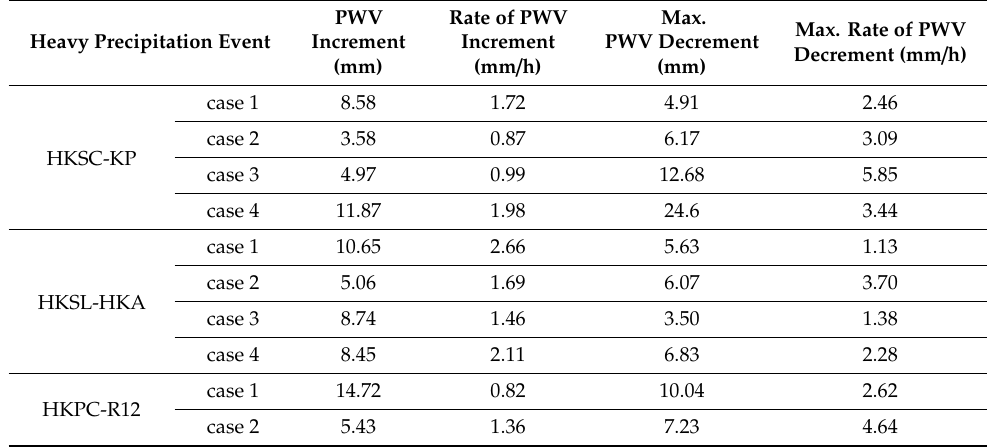
Table 7. Results of four factors prior to 10 heavy precipitation events occurred at the three pairs of co-located GNSS / weather